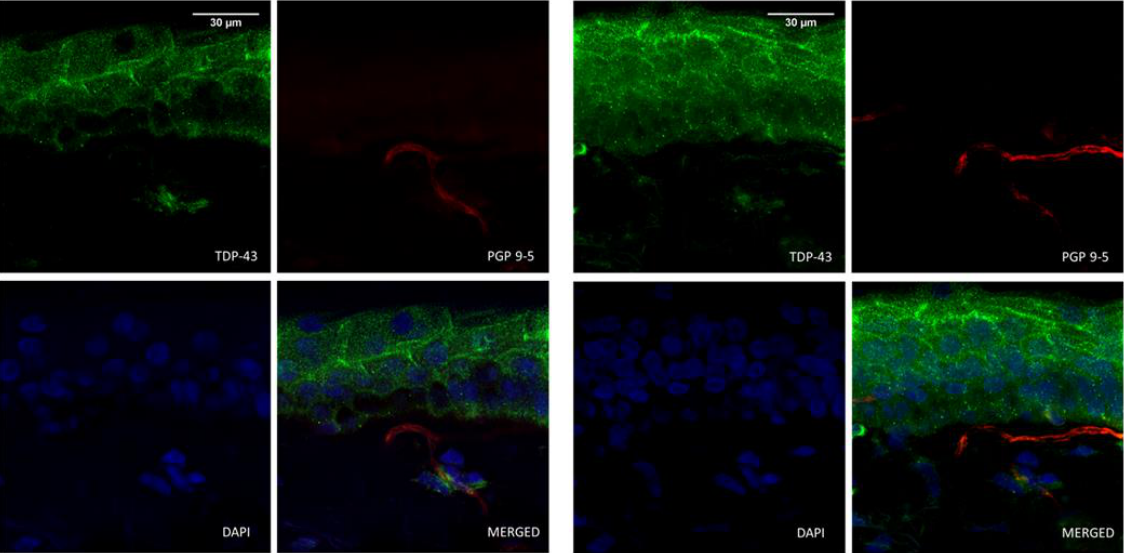
Figure 5. Representative images of ALS skin sections immunohistochemically labeled for PGP 9.5 (in red) to identify the innervation and for TDP-43 (in green). In the images, subepidermal nerve plexus and intraepidermal nerve fibers are shown with no colocalization of TDP-43 immunoreactivity.